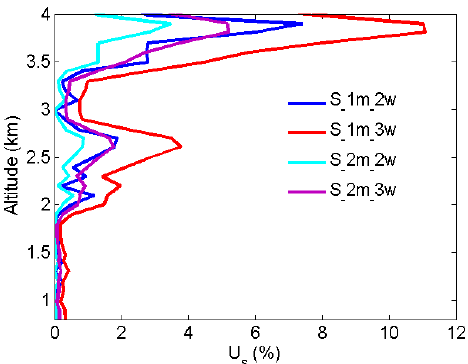
Figure 11. NO 2 number density relative uncertainty owing to the noise of signals with an average of 1 and